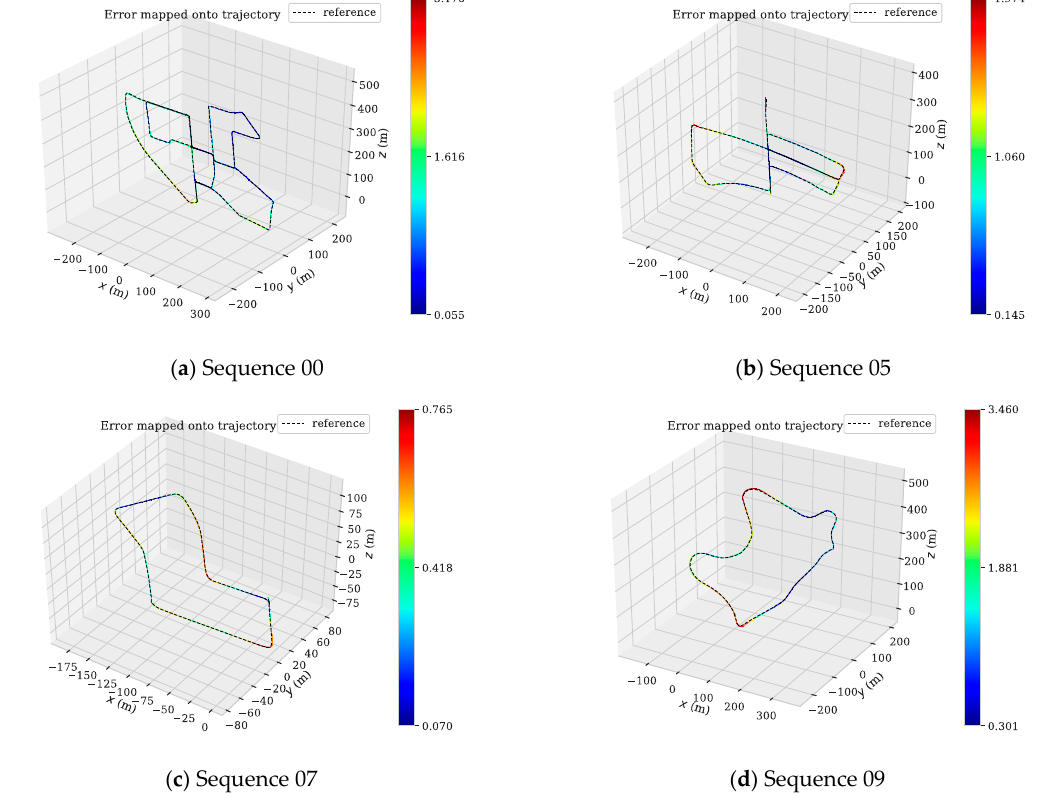
Figure 17. ( a – d ) Motion trajectory of DMS-SLAM on the 00, 05, 07, 09 sequences in the KITTI dataset. Where x and z represents the horizontal direction, and y represents the vertical horizontal direction.